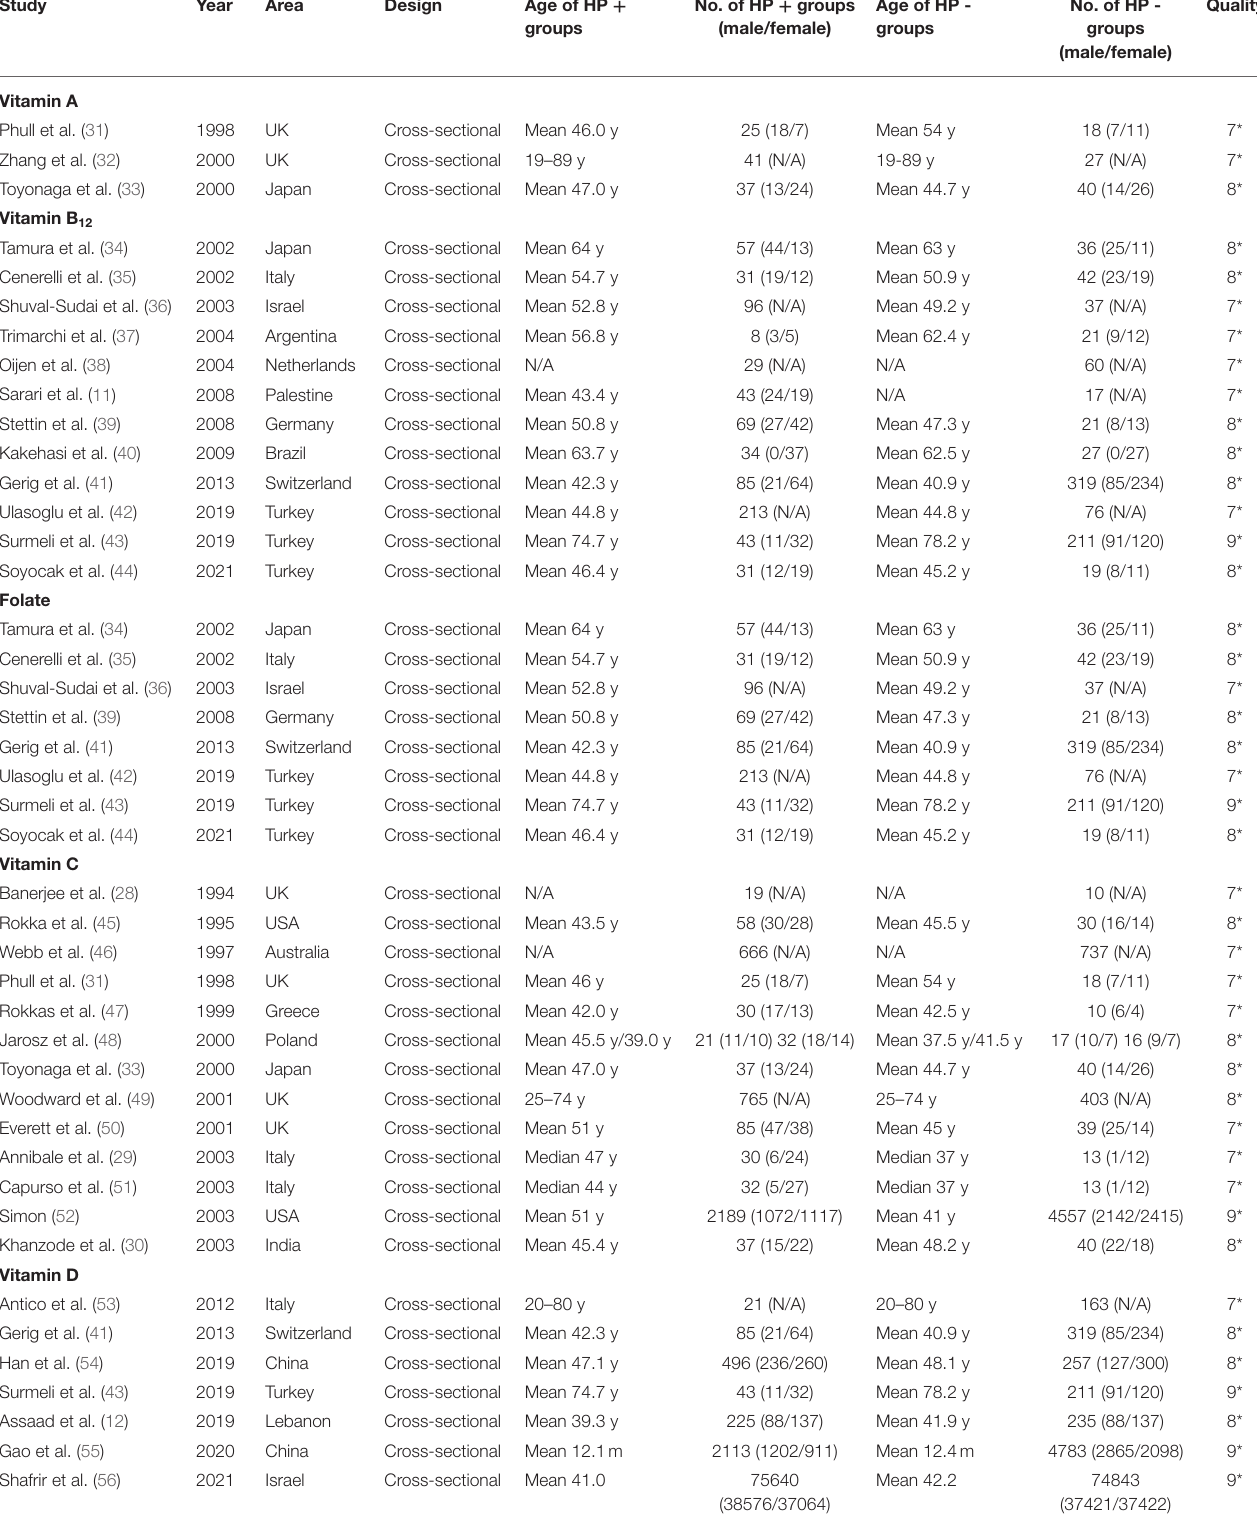
TABLE 1 | Basic characteristics of studies comparing serum vitamin levels between H . pylori + groups and H . pylori - negative groups.